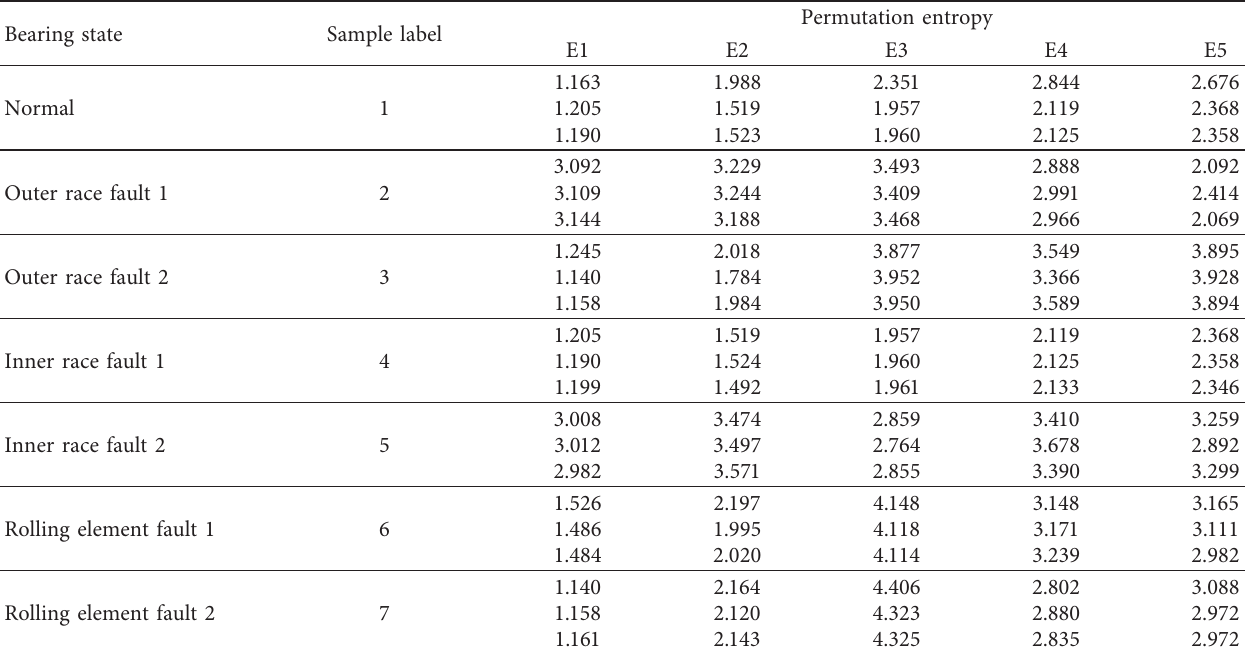
Table 7: Feature